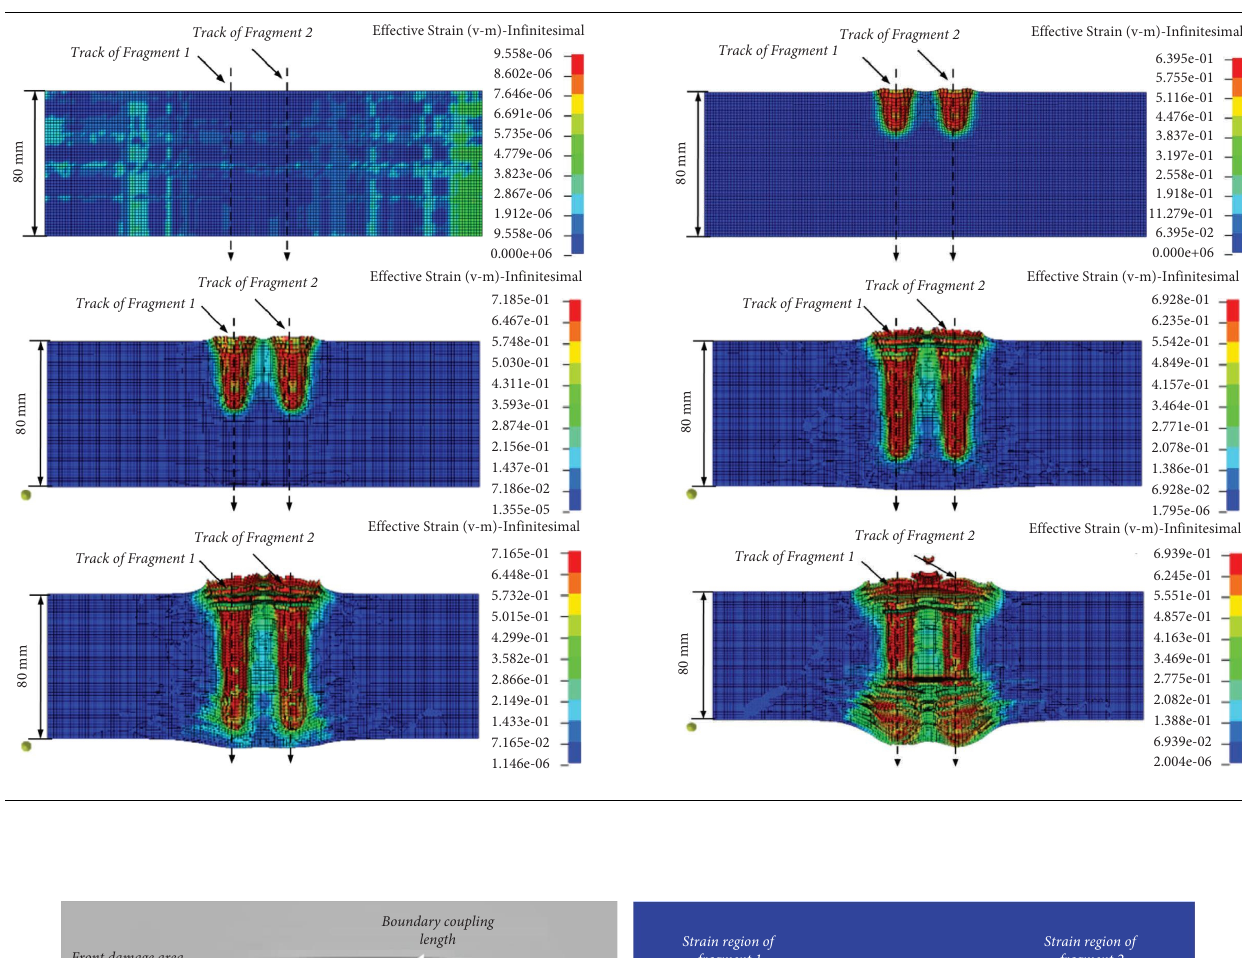
Table 8: Joint damage process of coplanar penetration.